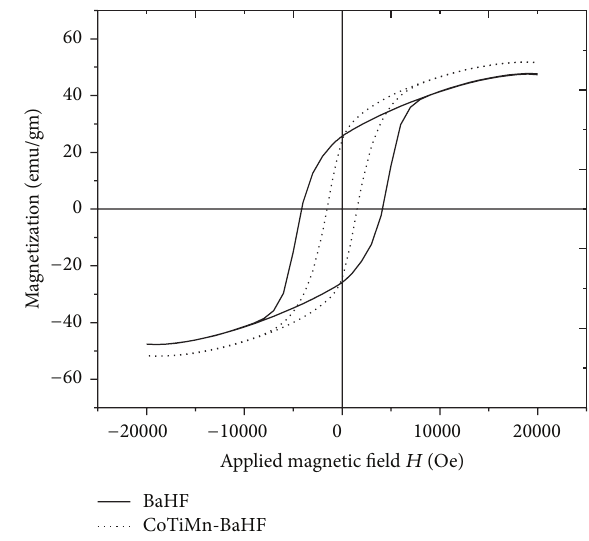
Figure 2: XRD of BaHF and CoTiMn-BaHF.